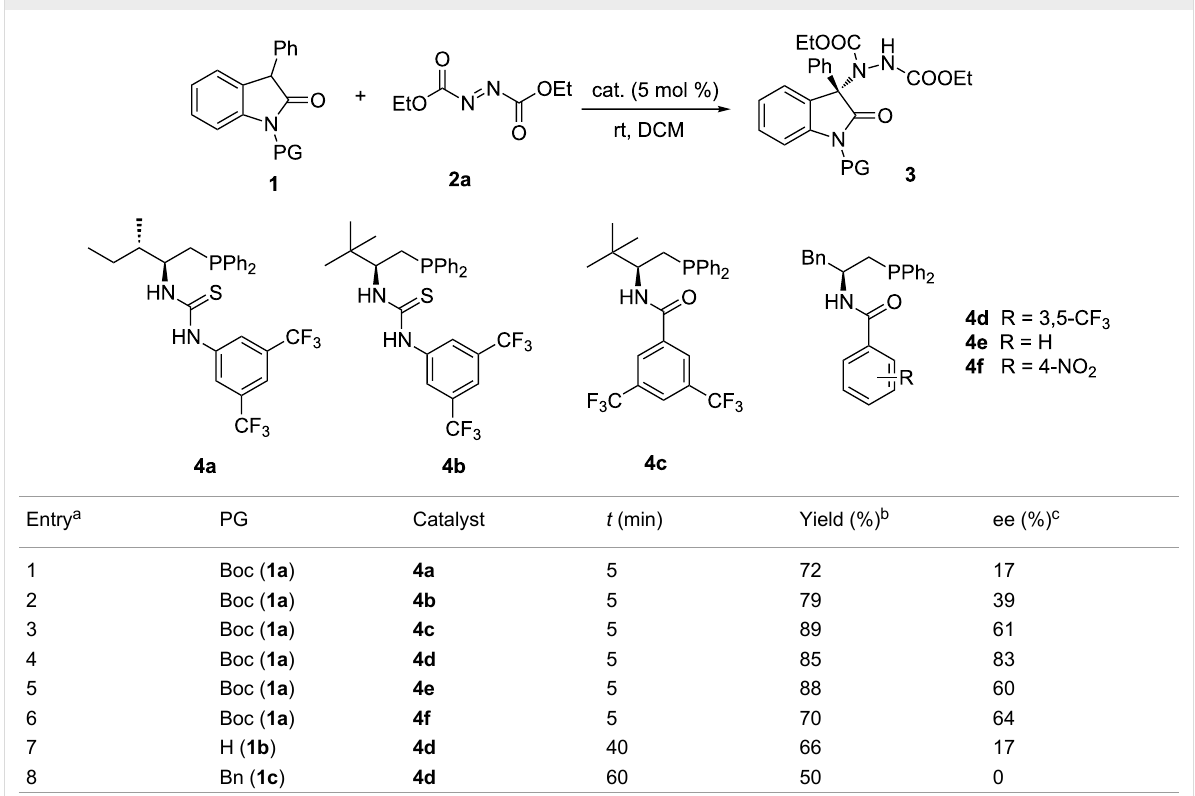
Table 1: Catalyst